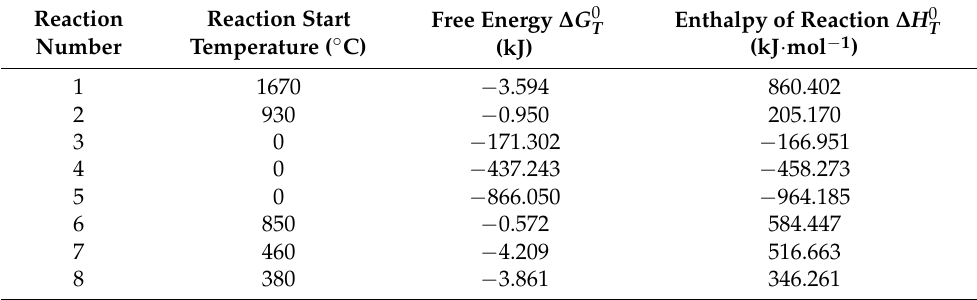
Table 2. Starting temperature and free energy change of chemical reaction of phosphogypsum